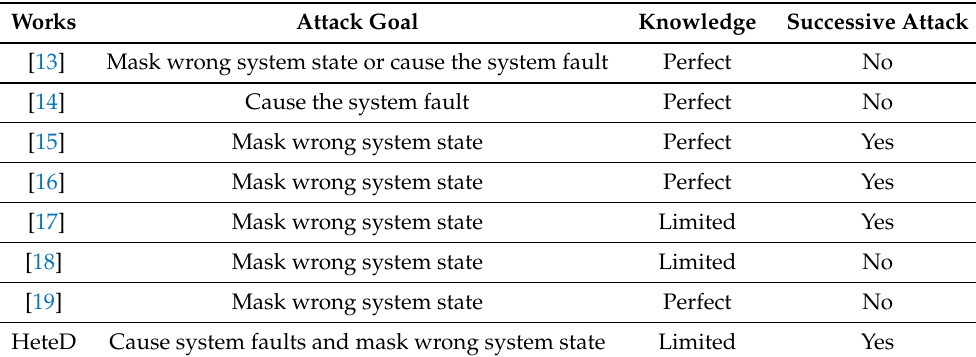
Table 4. Characters of previous FDI attacks.